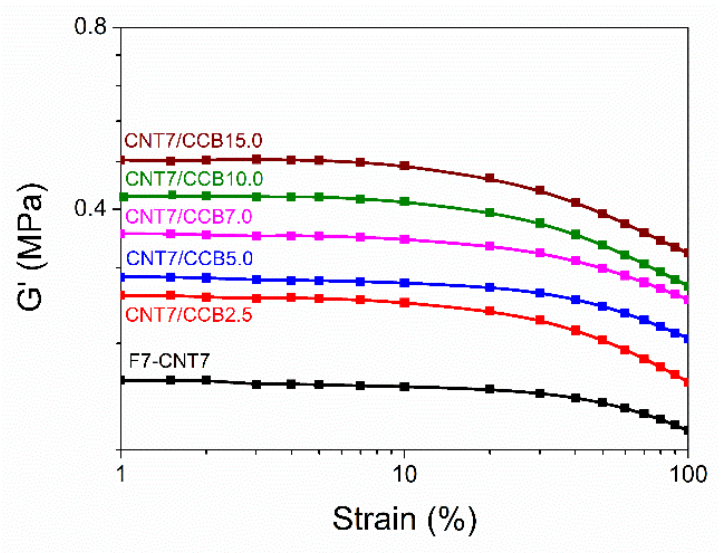
Figure 5. Storage modulus as a function of strain amplitude of ENR–FeCl 3 filled with CNTs (F7-CNT7) and CNT–CCB hybrid fillers with various CCB loadings at 2.5, 5.0, 7.0, 10.0 and 15.0 phr. Table 4. Payne effect of ENR ‐ 50 compounded with FeCl 3 (ENR–FeCl 3 ) filled with CNTs (F7 ‐ CNT7) and CNT–CCB hybrid fillers with various loadings of CCB.